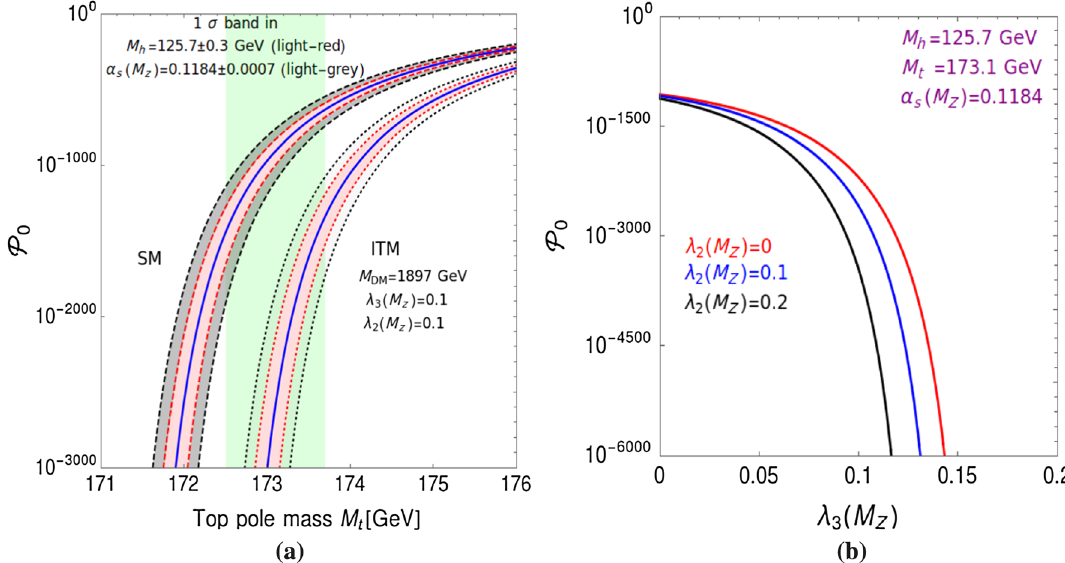
Fig. 4 a Tunneling probability P 0 dependence on M t . The left band (between dashed lines) corresponds to the SM. The right one (between dotted lines) is for IT model for a DM mass M H = 1897 GeV. Dark